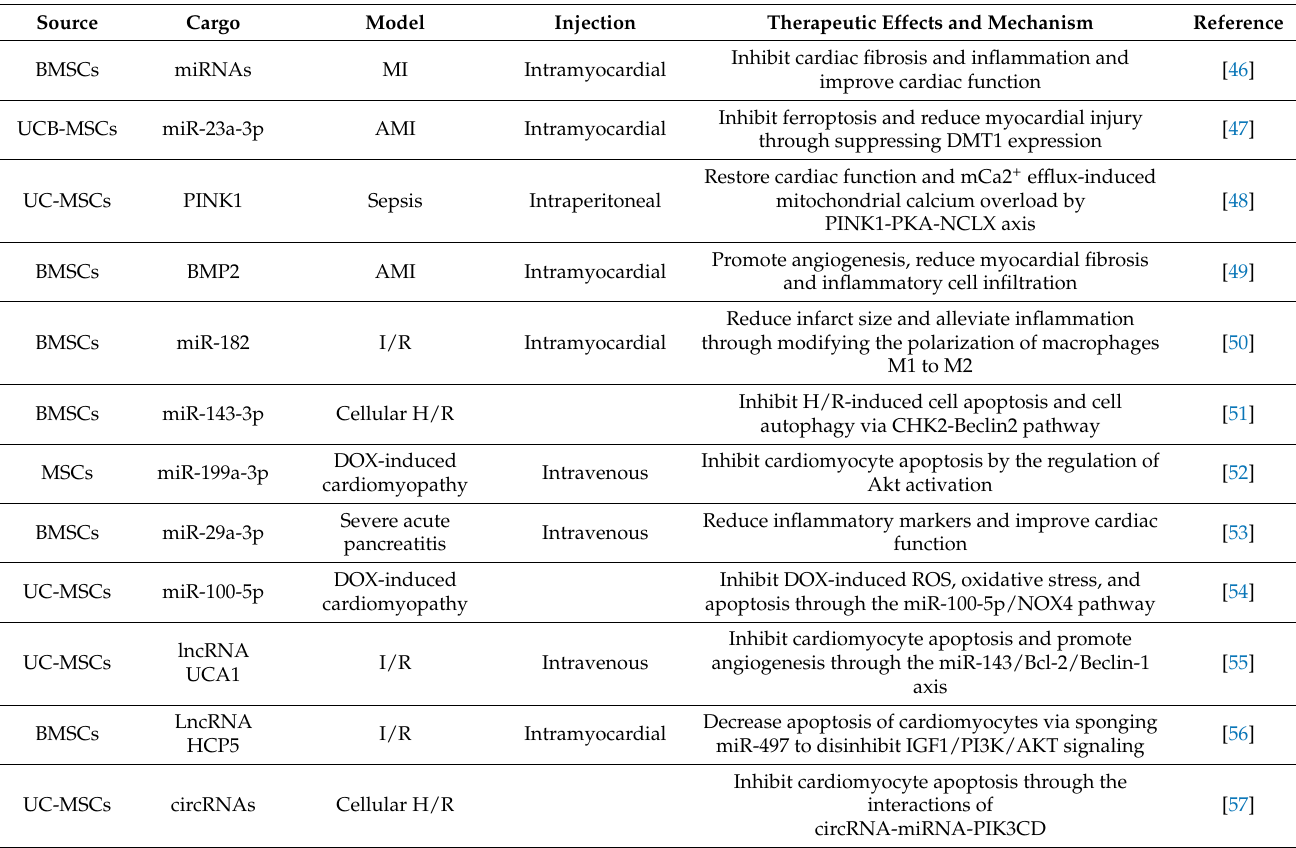
Table 1. Role of natural EVs from different sources for cardiac